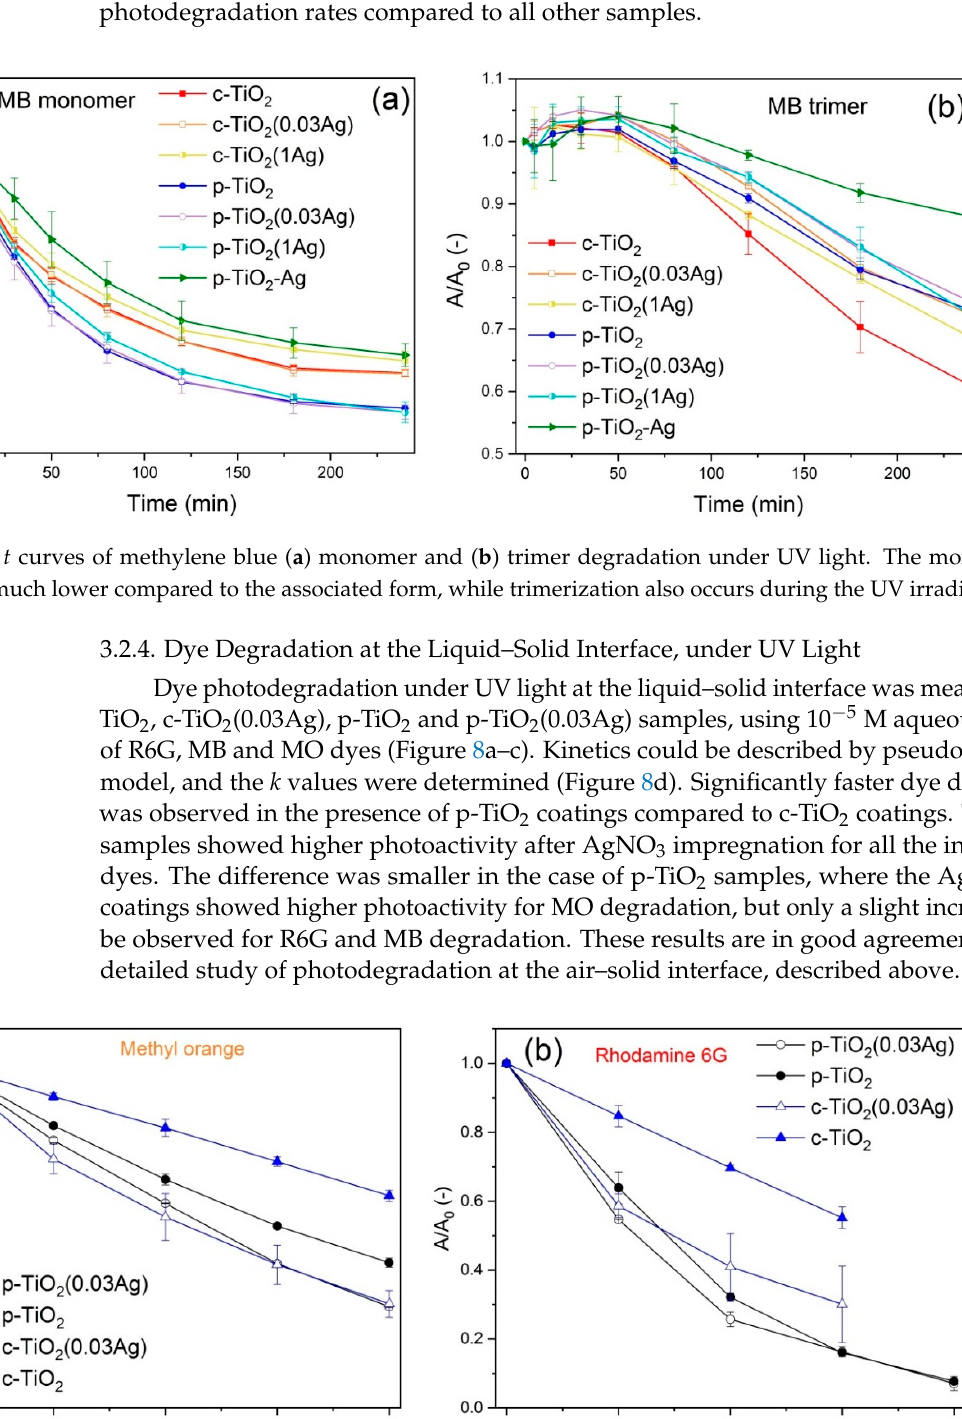
Figure 8. A/A 0 − t curves of ( a ) methyl orange, ( b ) Rhodamine 6G and ( c ) methylene blue dye photodegradation at the liquid–solid interface, in the case of different TiO 2 samples; ( d ) kinetics of dye degradation: first order k values. 4. Discussion The p-TiO 2 coatings showed higher photoactivity than the c-TiO 2 coatings under both UV and visible light. The main reason for this is their different pore structure: p-TiO 2 contains slightly bigger mesopores, as shown in our previous paper [18]. Fur- thermore, according to the XPS results (Table S1, Supporting information), there are sig- nificantly more Na ions present in the c-TiO 2 coatings, which can also contribute to their lower photoactivity. There were differences in the dye adsorption capability and the amount of associated dye molecules present in these two types of coatings (see Section 3.2.1), also caused by the different pore structures, which can also contribute to the dif- ferences in the photodegradation test results. Silver addition to the TiO 2 coatings had different effects on the photoactivity, de- pending on the type of coating, the silver modification method, and also the dye and the wavelength of light used in the photodegradation tests. The degradation rate constants and the quantum efficiency and quantum yield val- ues of the Rhodamine 6G dye photodegradation tests show that under both UV and vis- ible light the c-TiO 2 (0.03Ag) and c-TiO 2 (1Ag) samples had increased photoactivity com- pared to c-TiO 2 samples. In contrast, p-TiO 2 (0.03Ag) and p-TiO 2 (1Ag) samples show similar or lower photodegradation rates than p-TiO 2 samples. This shows that the silver modification by impregnation method caused a better improvement in the photoactivity of c-TiO 2 coatings, compared to p-TiO 2 coatings. This was also confirmed by the photo- degradation tests in different dye solutions. This is mainly caused by the differences of